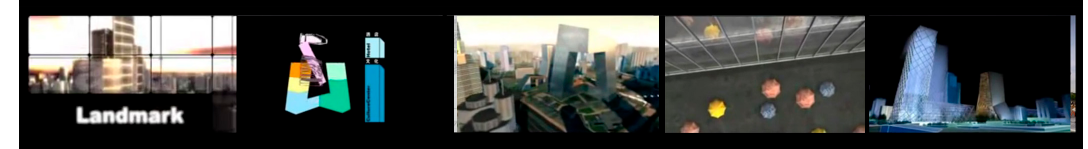
Figure 2. OMA, CCTV Headquarters in Beijing. Movie by Neutral (3:08),